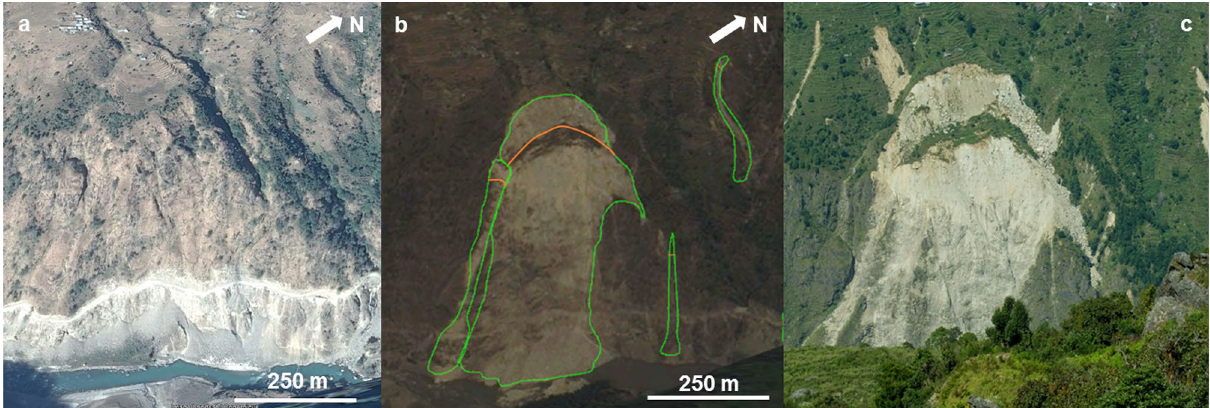
Figure 6. Example of coseismic landslides mapped as polygons in Rasuwa District. ( a ) Satellite image from Google Earth with pre-seismic condition (date 12/12/2014, map data: Google, 2020 CNES / Airbus, https ://earth .googl e.com/web/). ( b ) Satellite image from Google Earth, with an oblique view of the slope (date 5/25/2015, map data: Google, 2020 Maxar Technologies, https ://earth .googl e.com/web/). Orange line delineates the scar sources. ( c ) Field photograph of the rotational slide made during the field activity carried out in October 2015 (photo by Frattini Paolo). The landslide on the west of the scar was not mapped in ( b ) because it was a post- monsoon landslide. (The figure was generated by using Microsoft PowerPoint 2013, http://www.micro soft.